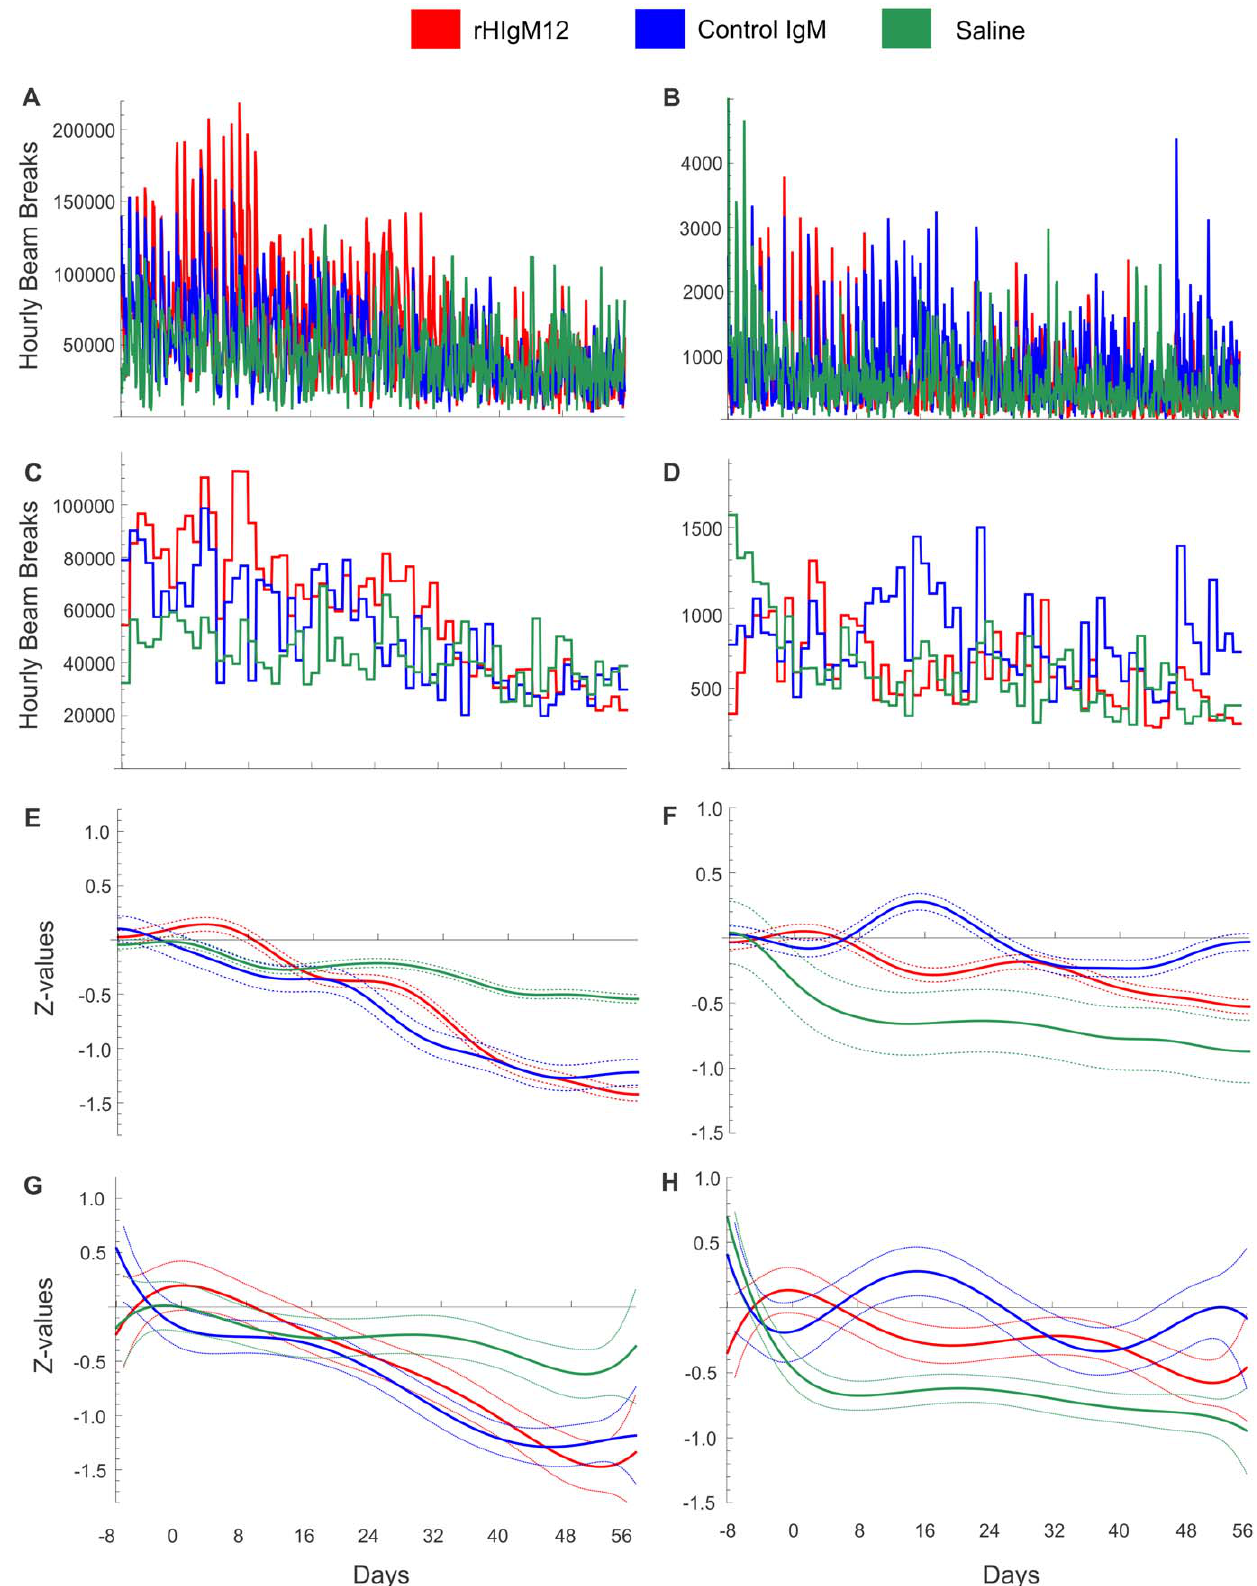
Figure 6. Normal, uninfected SJL mice have highly variable spontaneous activity which is not influenced by any treatment. Three groups of 5 uninfected SJL mice were placed in AccuScan activity monitoring boxes. Baseline measurements were collected over 8 days. After the treatment mice were monitored continuously over 8 weeks. None of the treatments induced changes in either horizontal (A, C, E and G) or vertical (B, D, F and H) activity. The pointwise 95% confidence bands are given for each day. doi:10.1371/journal.pone.0026001.g006 PLoS ONE | www.plosone.org